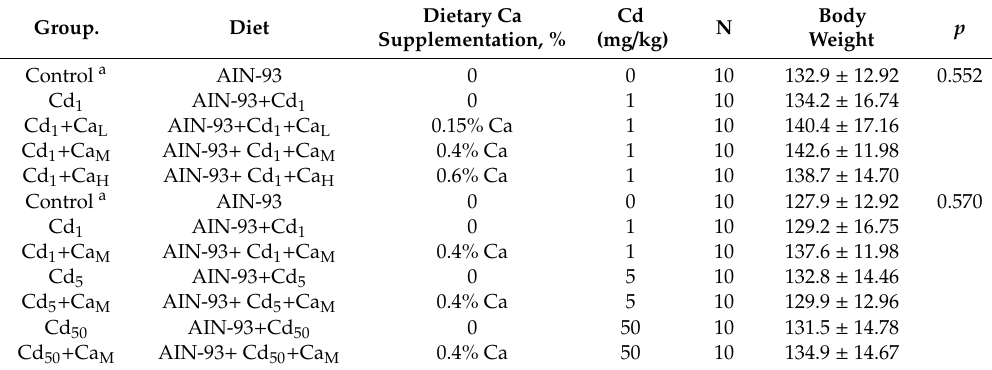
Table 1. Experimental